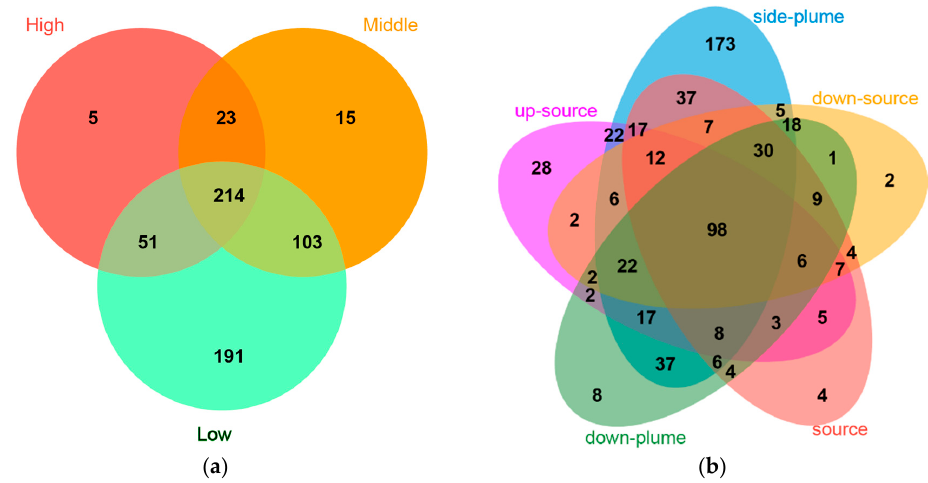
Figure 3. Venn diagrams showing the bacteria by ( a ) the degree of contamination and ( b ) locations.